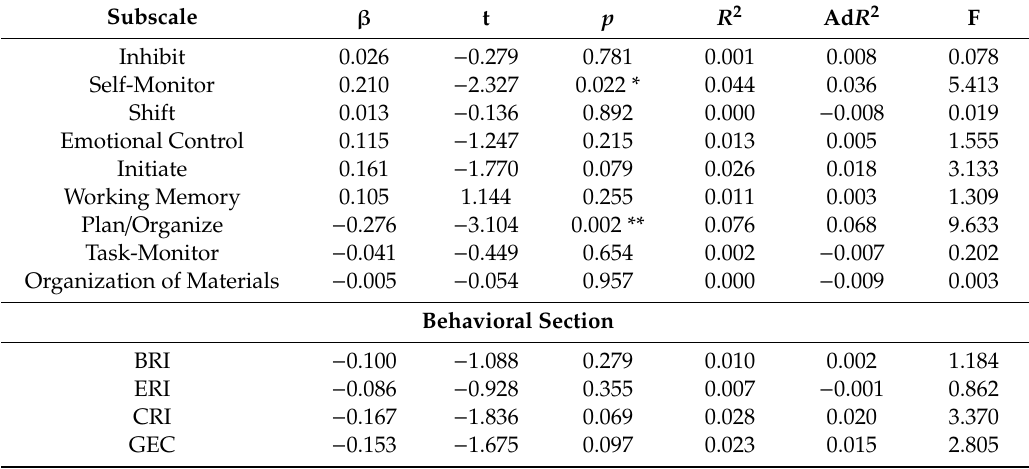
Table 7. Linear Regression Predicting the BRIEF-2 Scores by Age for the Children with ASD. Subscale